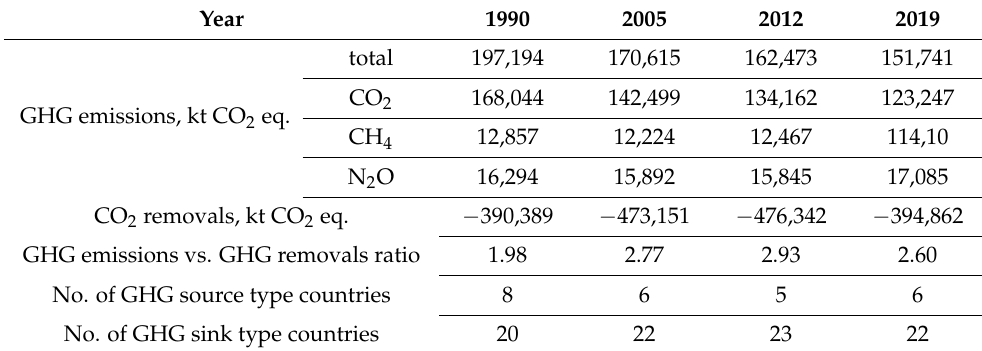
Table 1. GHG emissions vs. GHG removals evolution, by GHG type, EU-27 + UK [24].